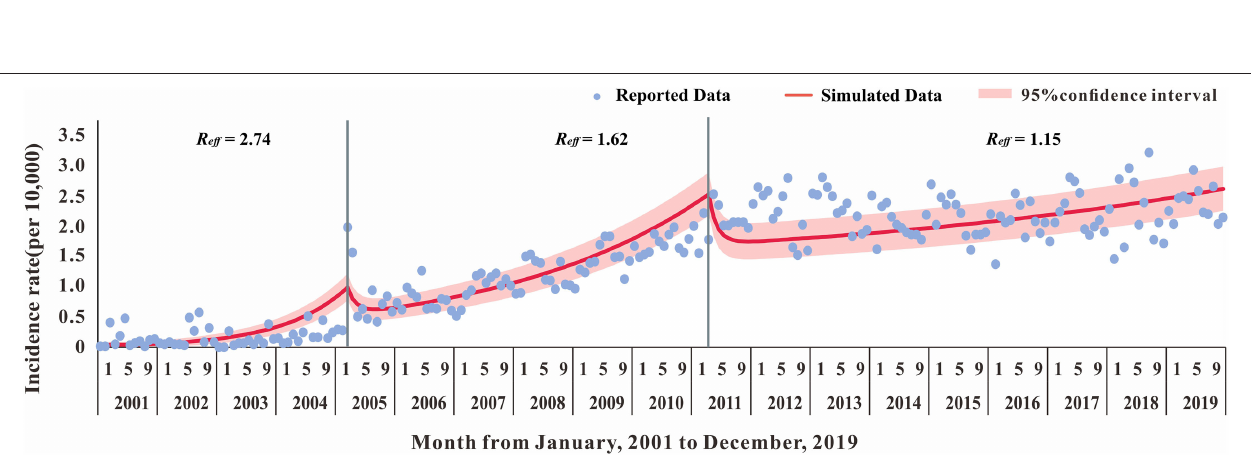
Frontiers in Public Health |